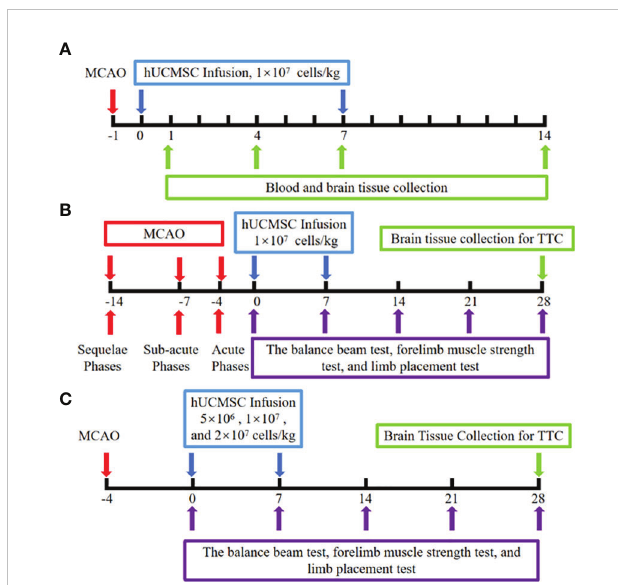
FIGURE 1 Schematic illustration of hUCMSCs treatment for ischemic stroke experiment. (A) The mechanism experiment; (B) The time windows experiment; (C) The dose-effect relationship experiment; The red arrows indicate the model establishment time points; The blue arrow indicates the time point of injection of hUCMSCs or PBS; The purple arrows indicate the time points of motor/neural function testing; The green arrow indicates the time point of sample collection and